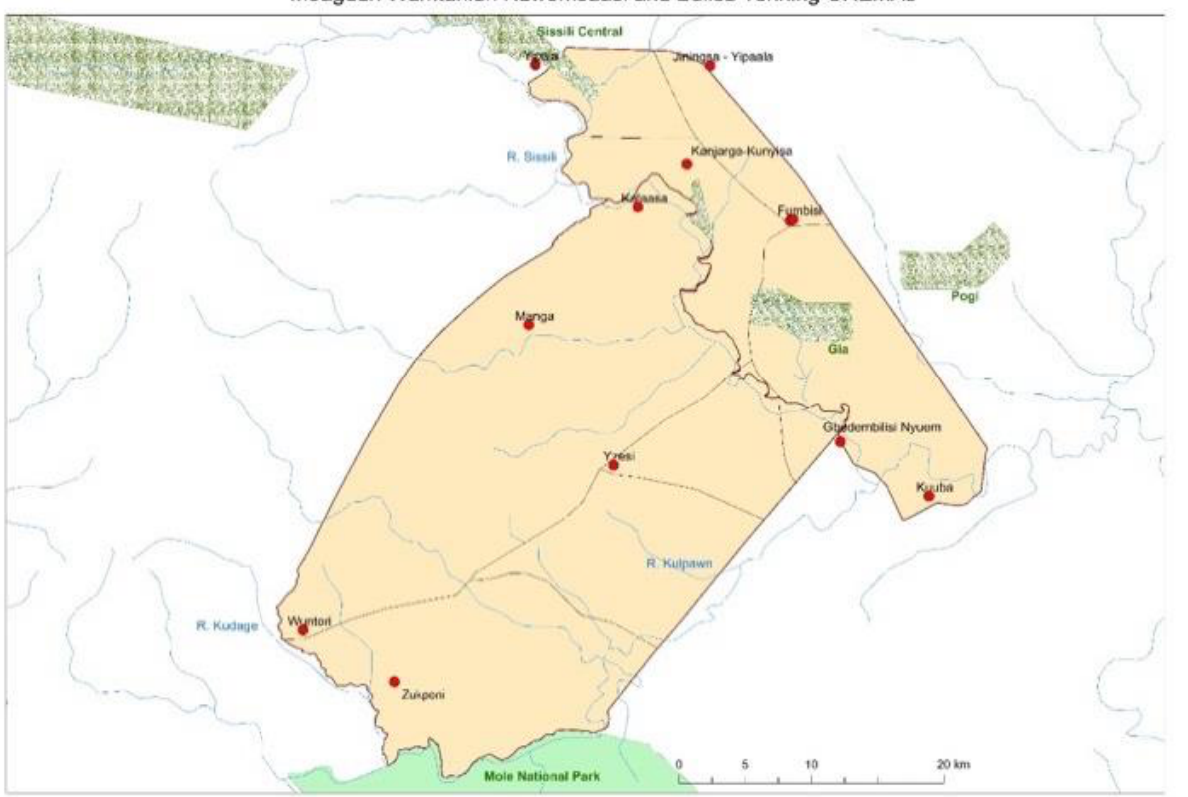
Figure A2. Map B: Builsa Yenning — Moagduri Wuntanluri Kuwomsaasi (BY-MWK) CREMAs.